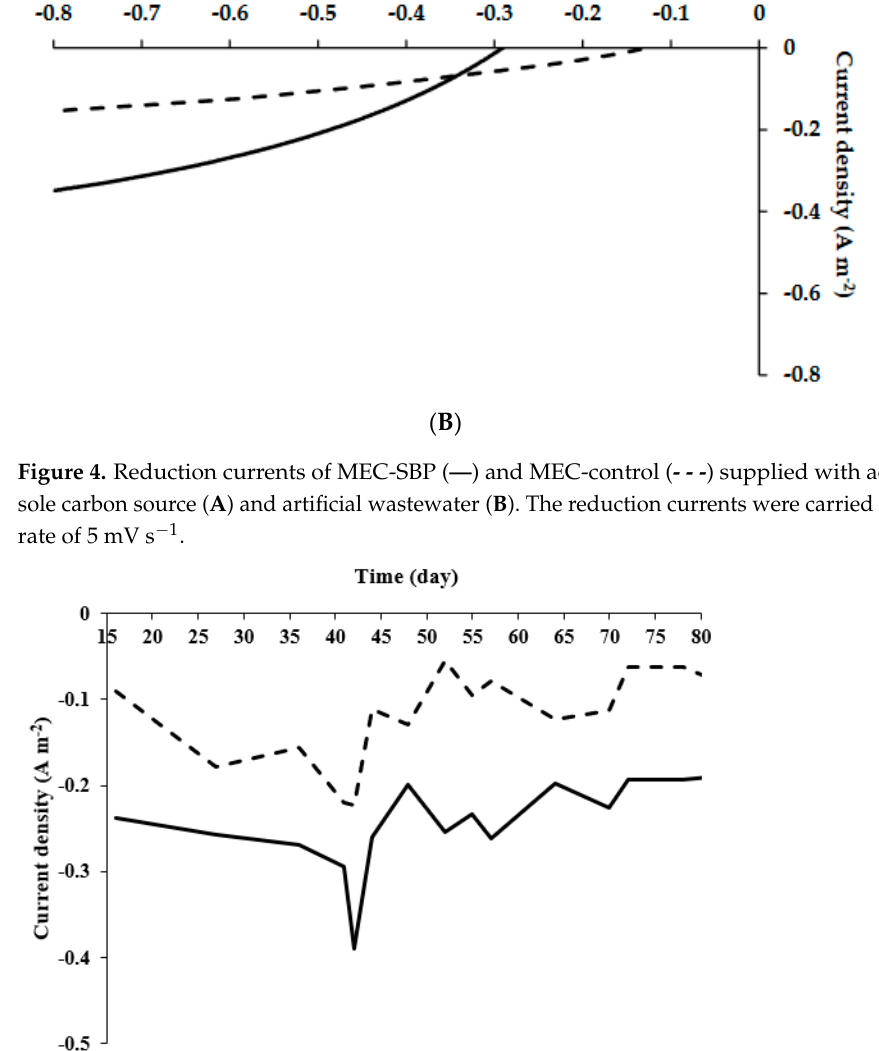
Figure 5. Reduction of protons to hydrogen currents under an applied potential of 0.6 V in MEC-SBP ( — ) and MEC control ( - - - ) during operation of 78 days. Lim et al. (2022), constructed an MEC with two plain carbon-felt structures as anode and cathode (size 4.8 × 4.8 × 0.2 cm, projected area 25 cm 2 ). The MEC working volume was 25 mL. The hydrogen evolution rate was 0.32 ± 0.01 m 3 m − 3 day − 1 (6–11 days) and 0.37 ± 0.02 m 3 m − 3 day − 1 (12–14 days) [13]. Yasri and Nakhla (2017) investigated an MEC employ-